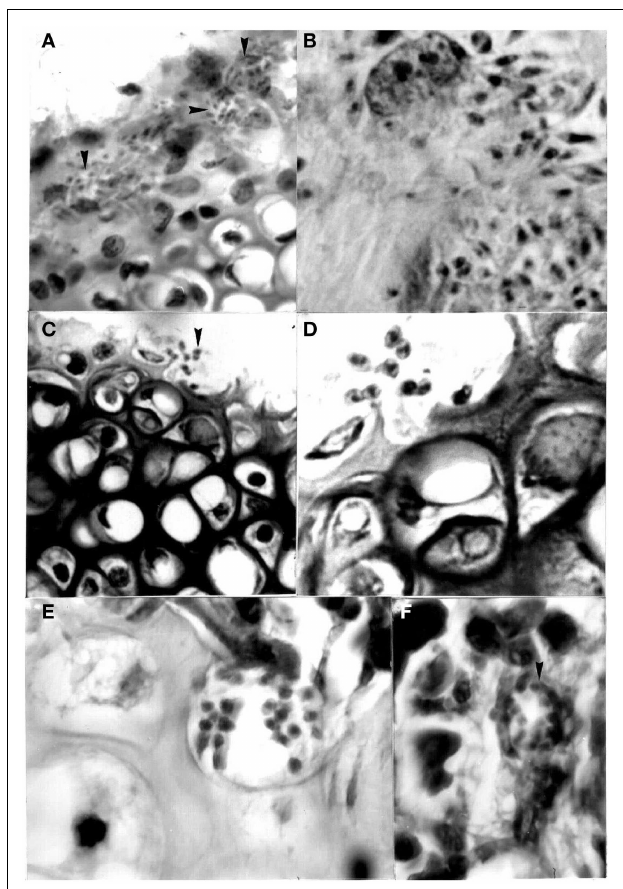
FIGURE 6 | Pseudocysts with stages (arrows) of Trypanosoma cruzi in sternum of mice experimentally infected with different isolates . (A) Perichondrium with nests showing amastigotes and intermediate stages in chondroblasts (400 × ; HE); (B) same stages in stroma of perichondrium and in the cytoplasm of a macrophage (1000 × ; HE); (C) and (D) two broken chondrocytes with several amastigotes and one flagellated stage (400 × and 1000 × , respectively; HE); (E) several amastigotes in a osteocyte (1000 × ; HE); (F) pseudocyst with amastigotes in the bone marrow (1000 × ;